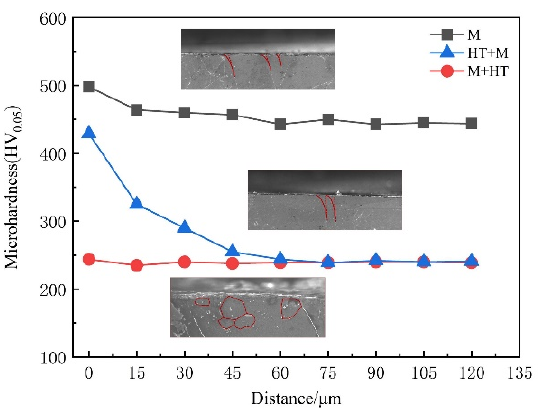
Figure 7. Microhardness distribution of the cross-section for M, HT + M, and M + HT conditions.